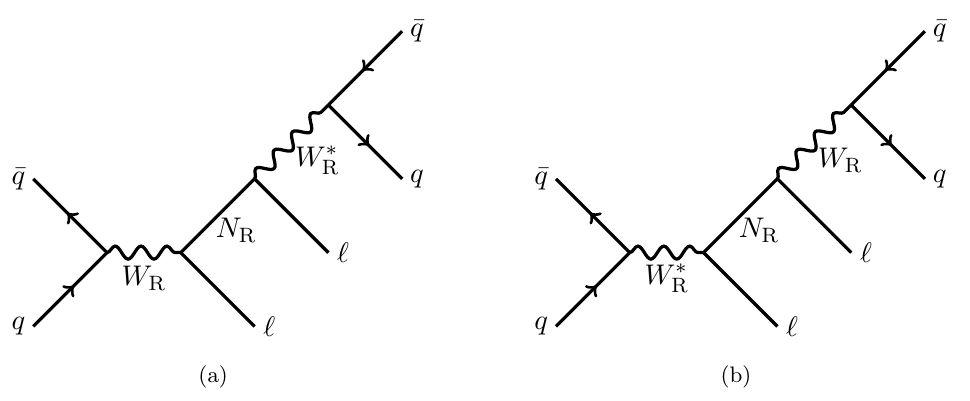
Figure 1 . The KS process, for (a) the m W